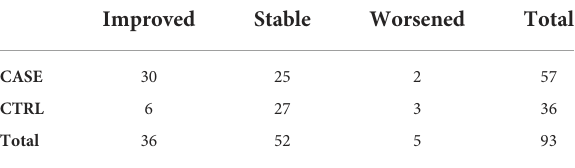
TABLE 4 MTS variation 1 month after surgery in CASEs and CTRLs.